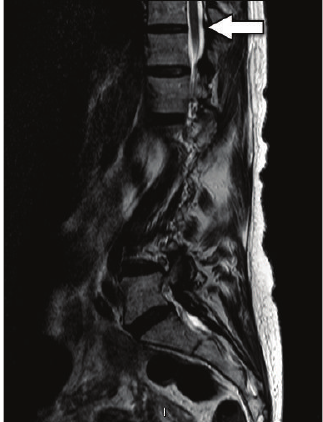
Figure 2: Preoperative sagittal T2 Magnetic Resonance Image. Note theabsenceofstenosisinthemidlineofthelowerthoracicspine.The arrow points to the T10-11